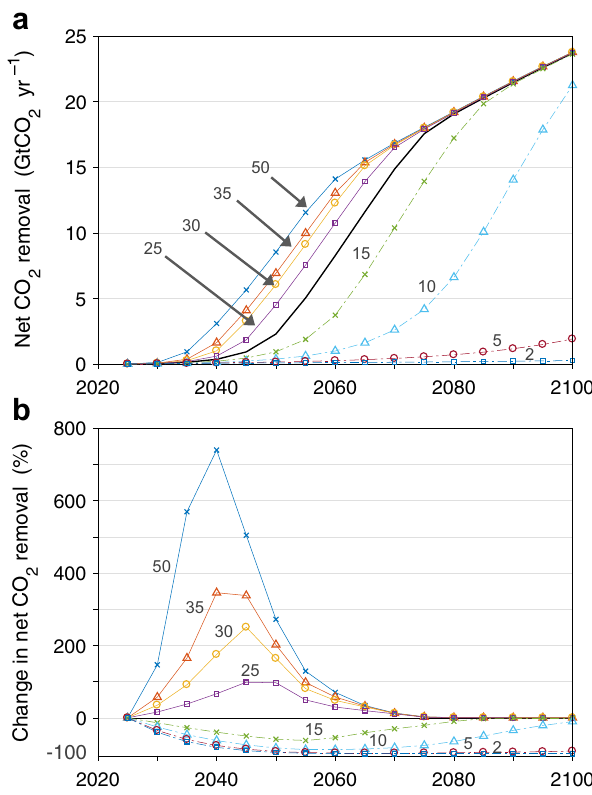
Fig. 8 Net CO 2 removal sensitivity to industry growth rate. a Net CO 2 removal given variation in the maximum allowable industry growth rate, given in percent per year. Markers show the mean of all scenarios by year. The nominal growth rate (20% yr − 1 ) is denoted with an unmarked black line; varied growth rates are denoted with marked colored lines and labels. b Percent change in net CO 2 removal relative to the nominal case. Markers show the mean of all scenarios by year. Funding is from the club of